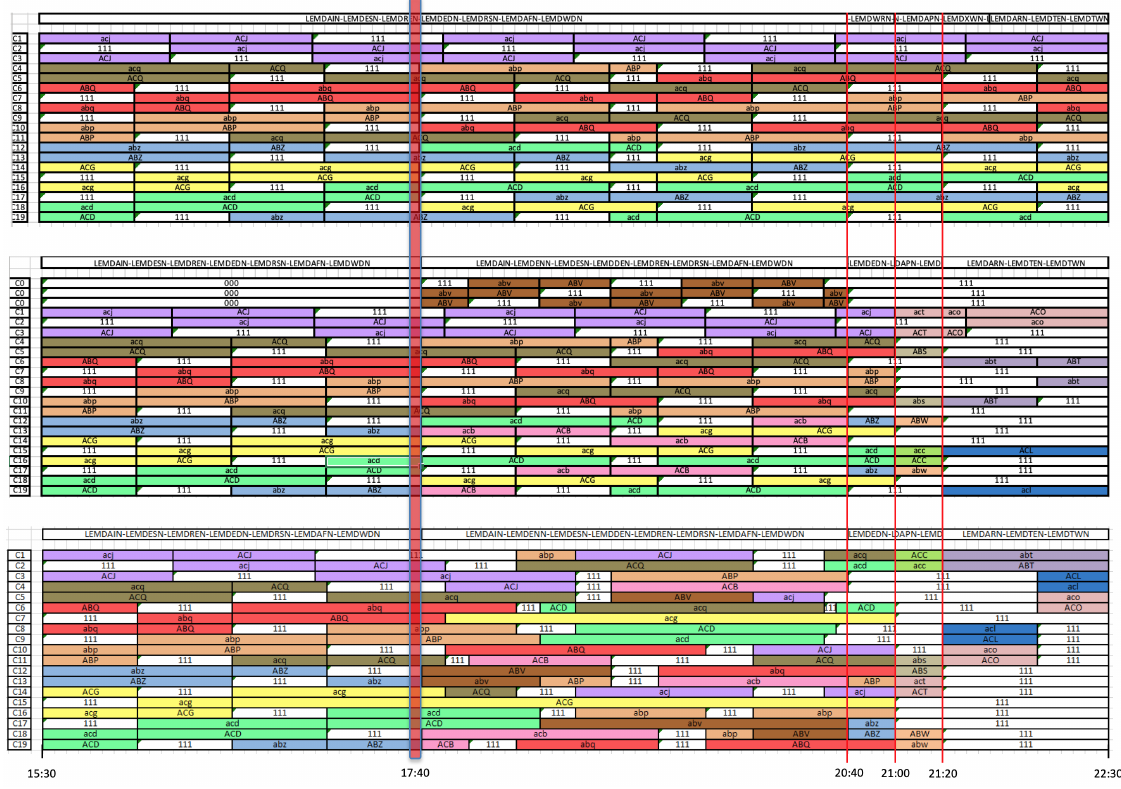
Figure 16. Solution before the incident, solution derived in Phase 1 and solution for Instance